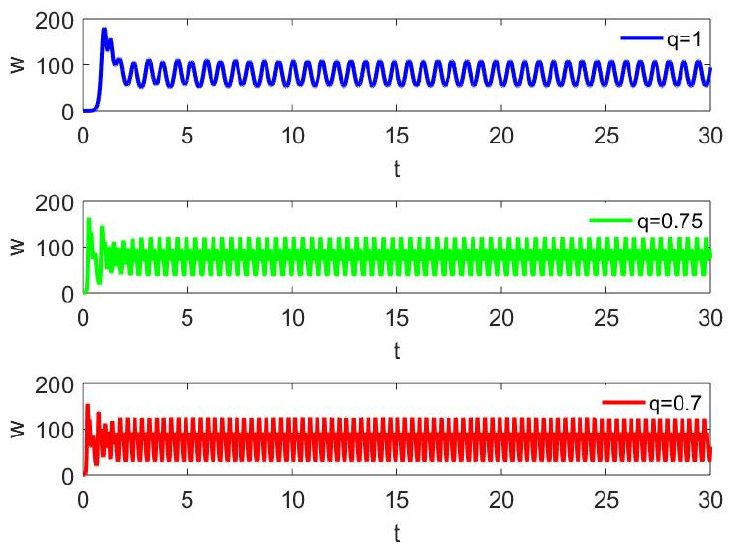
Figure 7. Time series of system (11) with the order q = 1, q = 0.75, and q = 0.7 when d = 3.